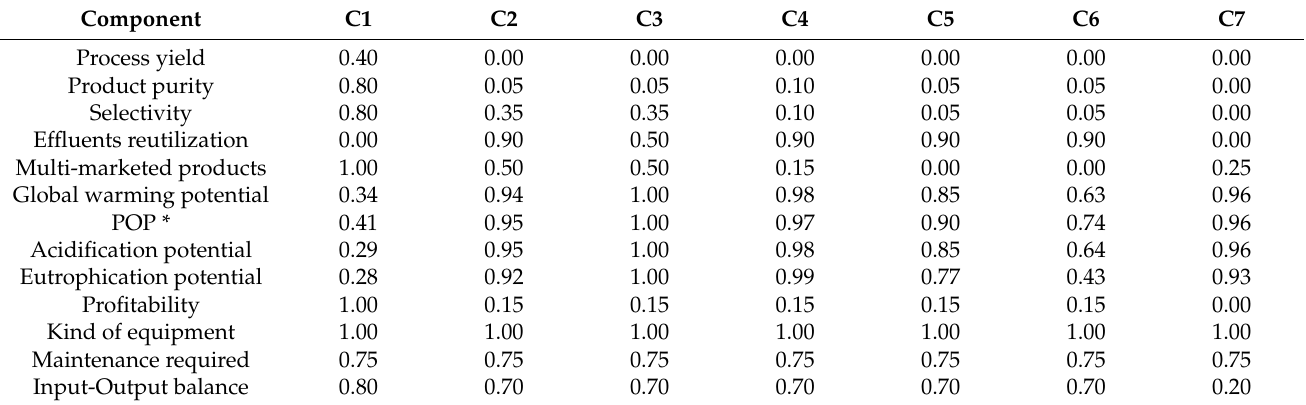
Table 3. Calculated Sustainability values for the defined components. Case study: corn oil valorization.